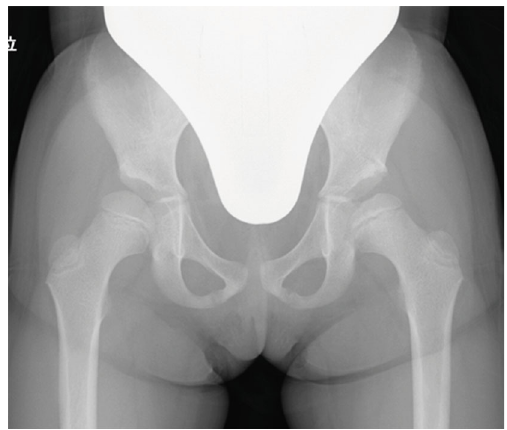
Figure 1: Preoperative radiograph of bilateral hips.